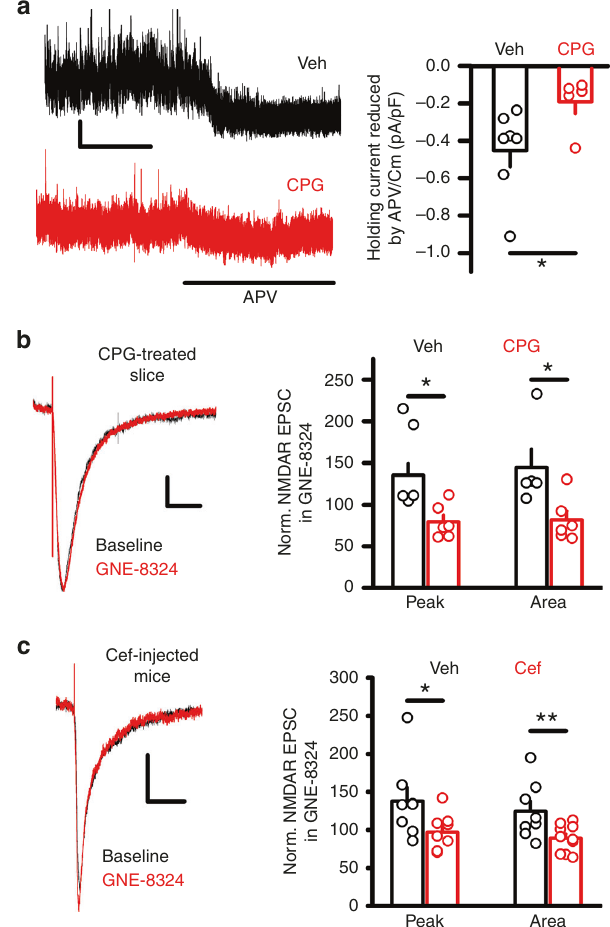
Fig. 4 Ambient glutamate and glutamate transporters play critical roles in GNE-8324 potentiation of NMDAR EPSCs in inhibitory neurons. a Reduced NMDAR responses to ambient glutamate after CPG treatment. Sample traces showing reduced D -APV-induced holding current changes in inhibitory neurons treated with CPG. Scale bars, 10 pA/500ms. D -APV- induced decrease in holding current was signi fi cantly smaller in CPG- treated neurons than in vehicle-treated neurons. * P < 0.05, unpaired t test. b CPG treatment eliminated GNE-8324 potentiation in the inhibitory neurons. Sample traces of NMDAR EPSCs before and after GNE-8324 application in the inhibitory neurons incubated with CPG. Scale bars, 20 pA/100ms. Compared to the robust potentiation in vehicle-treated neurons, CPG-treated neurons showed no signi fi cant GNE-8324 potentiation of NMDAR EPSCs. * P < 0.05, unpaired t test. c GNE-8324 potentiation was eliminated in the inhibitory neurons from mice injected with ceftriaxone (Cef). Sample traces of NMDAR EPSCs before and after GNE-8324 application from an inhibitory neuron in Cef-injected mouse. Scale bars, 10 pA/100 ms. Effect of GNE-8324 in inhibitory neurons from represent SEM (area) < 0.05, Ext/NAB-14 vs. Int/NAB-14, all one-way ANOVA with Dunnett's correction), demonstrating a preferential con- tribution of GluN2C/2D-containing NMDARs to NMDAR EPSCs in inhibitory neurons, consistent with previous fi nd- ings 54 – 57 . Next, we examined whether triheteromeric GluN1/2A/ 2D NMDARs have high glutamate sensitivity (see Methods).